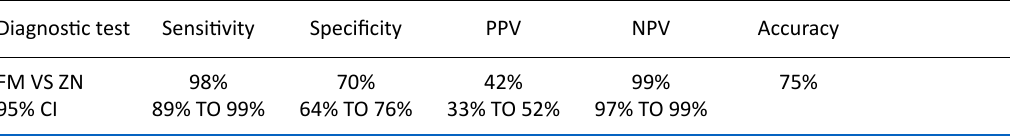
*Highly significant difference. Table 5. FM VS ZN microscopy Sensitivity, Specificity, Positive predictive value (PPV) & Negative predictive value (NPV) Diagnostic